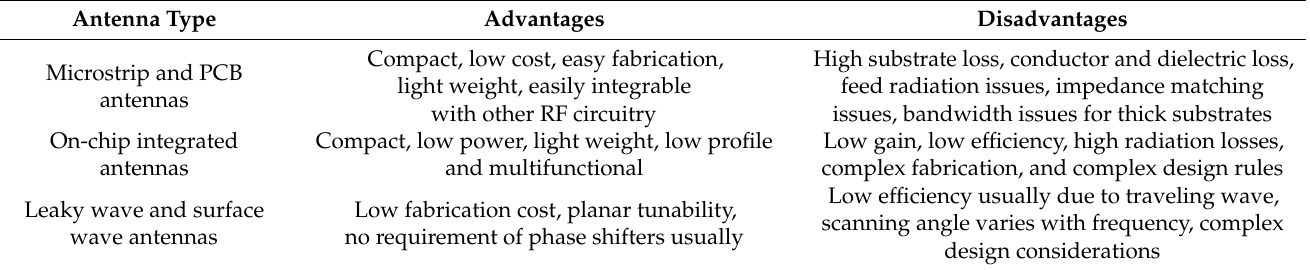
Table 3. Categories of 60 GHz mmWave antennas with benefits and drawbacks.